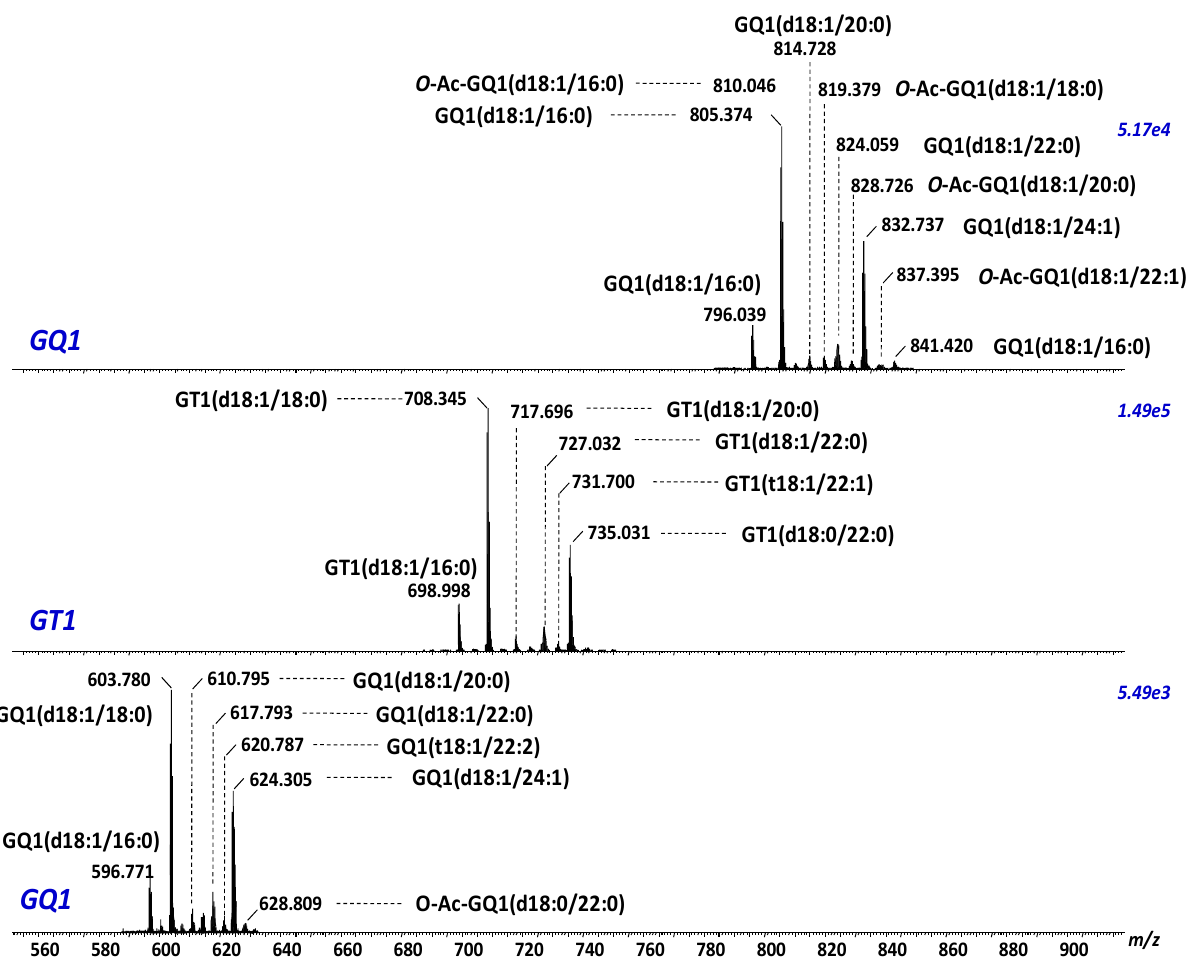
Figure 8. Extracted (-)nanoESI IMS mass spectra of triply charged GT1 (middle), GQ1 (up), and quadruply charged GQ1 (down) from the corresponding areas indicated in Figure 6 (reprinted with permission from [183]).